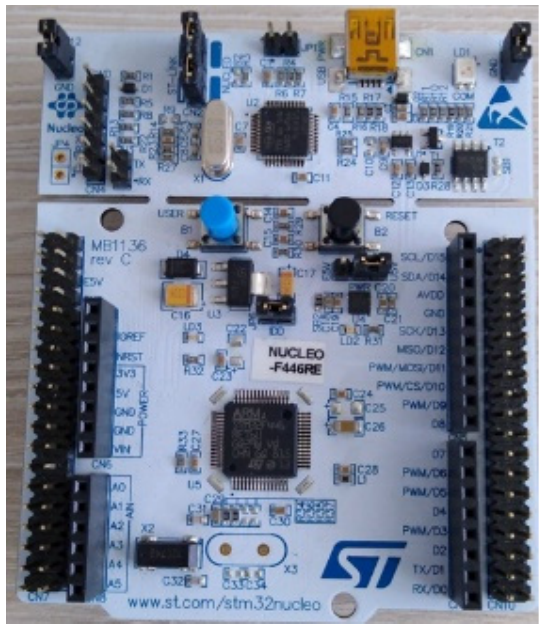
Figure 9. STM32 Nucleo F446RE microcontroller.